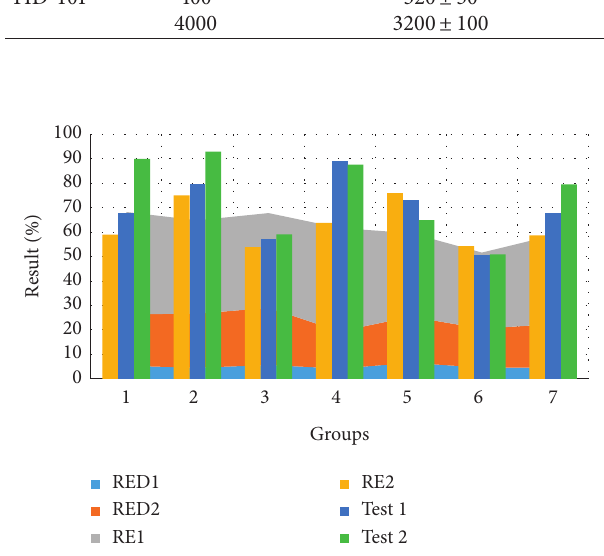
Figure 2: Drug release images obtained by mesoporous multi- functional nanomaterials loaded with